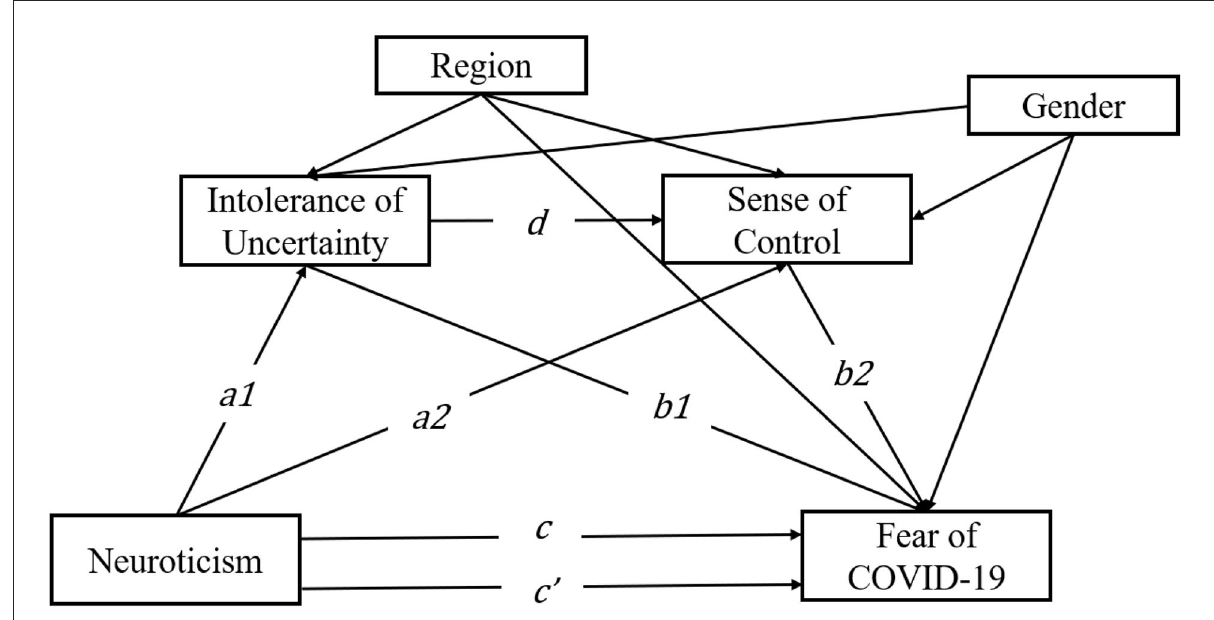
FIGURE1 Theoretical model. Intolerance of uncertainty and sense of control as a mediator between neuroticism and the fear of COVID-19. Region and gender were checked as covariates.